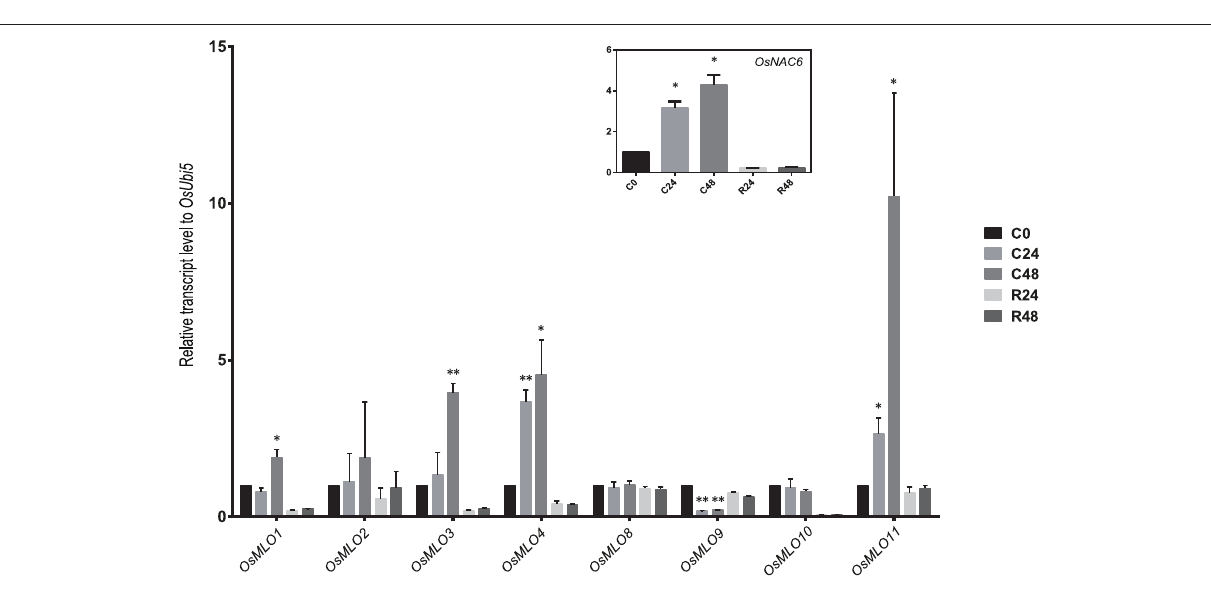
FIGURE 8 | Expression profiles of OsMLO genes under cold stress evaluated by real-time PCR. OsNAC6 served as a positive marker for cold-stress response. OsUbi5 was used as internal control. C, cold treatment; R, recovery. Numbers after C and R indicate time points (hours) after stress treatment. ** p < 0.01; *0.01 < p <